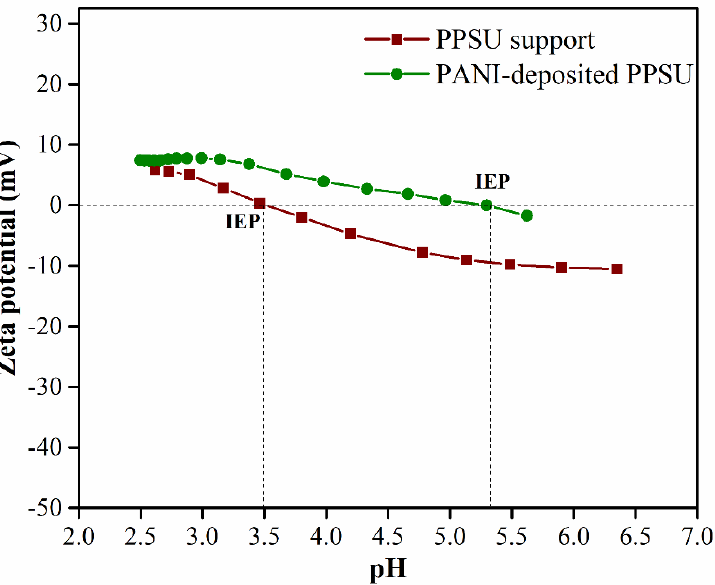
Figure 6. Zeta potentials of the PPSU support membrane and the PANI-coated PPSU membrane as a function of pH.